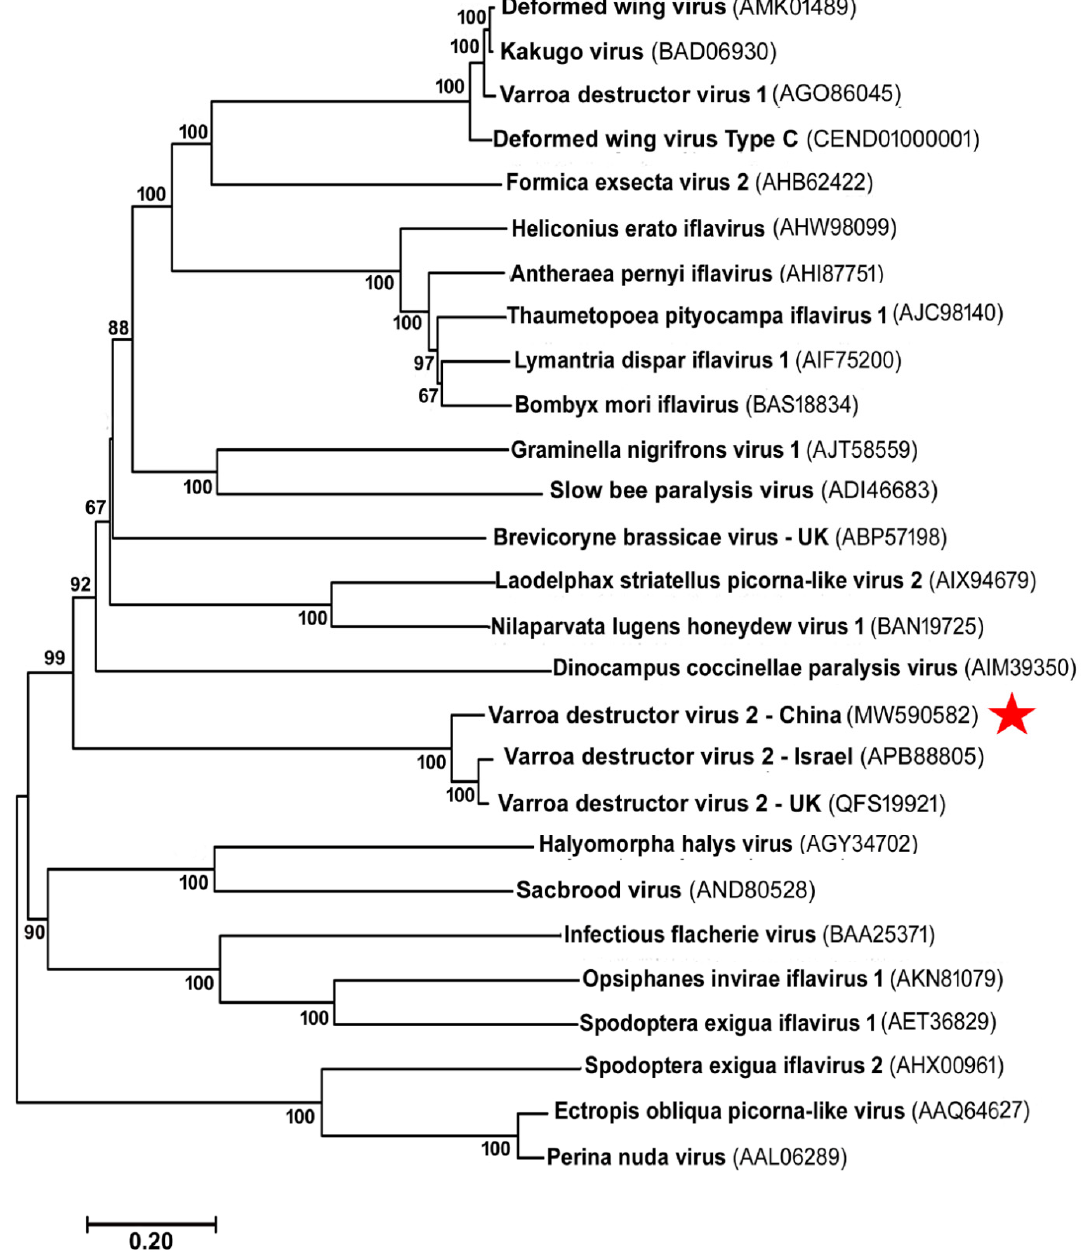
Figure 3. Phylogenetic tree of iflaviruses . The phylogenetic analysis was conducted in MEGA 7 based on the amino acid sequences of the polyprotein. The tree was constructed by the maximum likelihood method. The tree is drawn to scale, with branch lengths measured using the same units as those of the evolutionary distances that are used to infer the phylogenetic tree. The scale bar shows the number of substitutions per base. The reliability of the tree topology was determined by the bootstrap analysis (1000 replicates). The bootstrap values that were greater than 60% were given at the nodes. The names and accession numbers of the iflavirus taxa are shown and the red star is used to mark VDV-2 China.